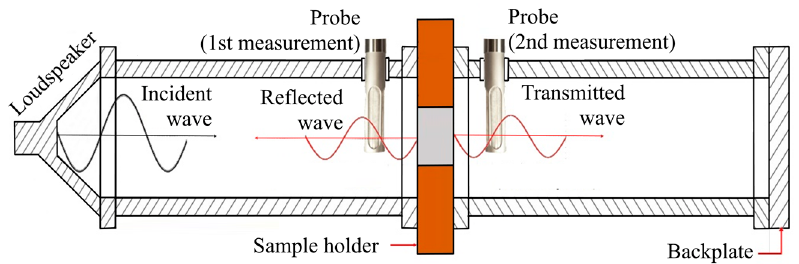
Figure 6. Detail of incident reflected and transmitted waves during transmission loss testing.